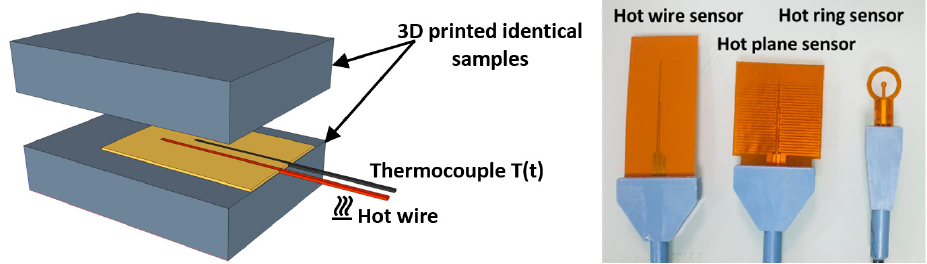
Figure 4. Hot probe transient technique with different geometries for thermal properties assessment of 3D printed PC samples.